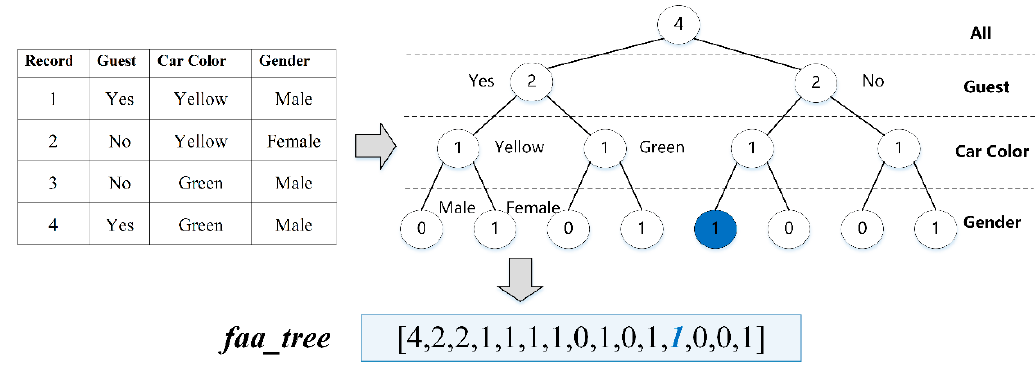
Figure 5. Illustration of the flattened attribute aggregation tree ( faa_tree ) structure.